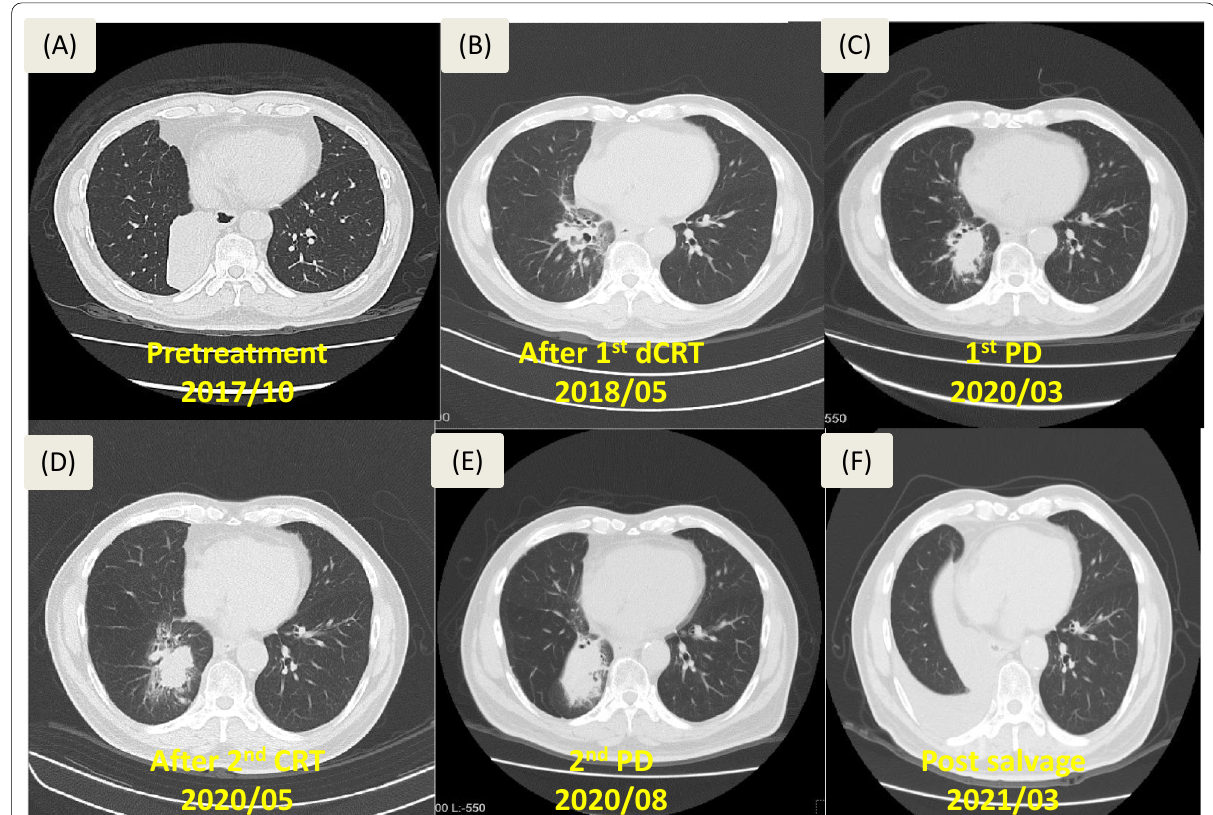
Fig. 2 Series of chest CT scan images showing the tumor morphology from pre‑treatment to pre‑operative state. a Before 1st dCRT on 2017/10/16; b after the 1st dCRT on 2018/05/15; c post‑dCRT surveillance showing tumor recurrence on 2020/03/04; d after the 2nd dCRT on 2020/05/18; e before salvage resection on 2020/08/18; f surveillance on 2021/03/22, 6 months after the